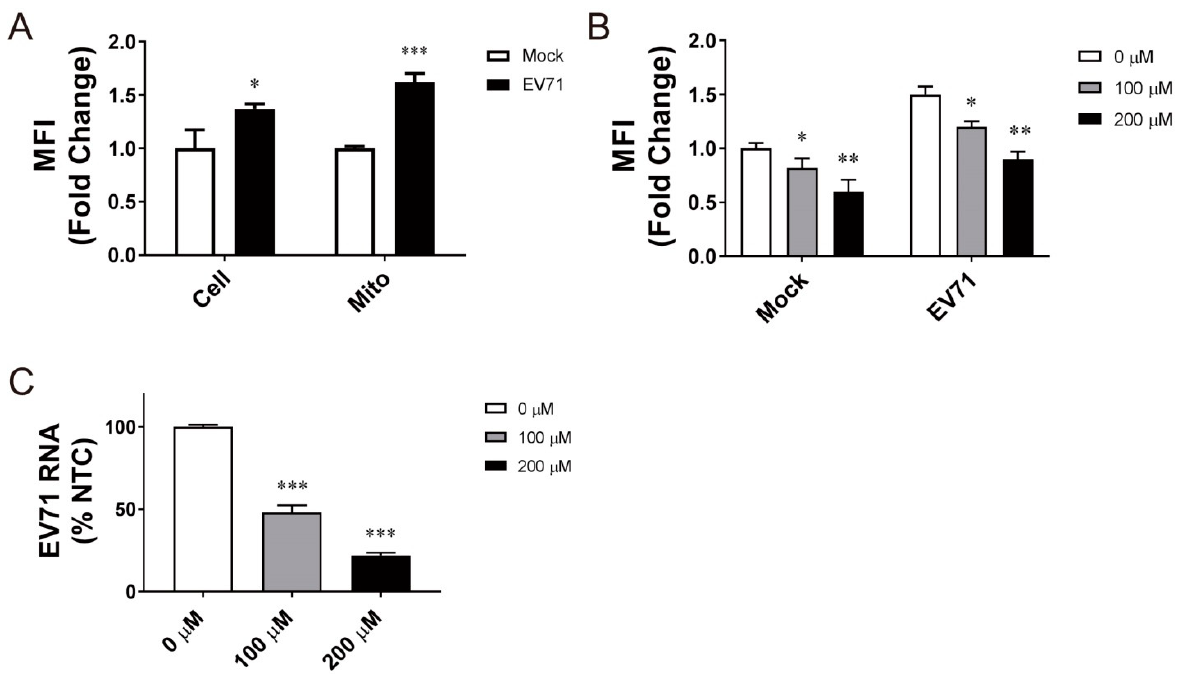
Figure 1. Mitochondrial ROS generation essential to EV71 replication. ( A ) Vero cells were mock infected ( Mock ) or infected ( EV71 ) with BrCr virus at an MOI of 1.25, and stained with CellROX Deep Red for quantification of total cellular ROS ( Total ) or with MitoSOX Red for quantification of mitochondrial ROS ( Mito ) at 24 h post-infection. The MFI is expressed as fold change relative to that of mock-infected cells. The results are mean ± SD, n = 6. * p < 0.05, *** p < 0.005 vs. mock-infected cells. ( B ) Vero cells were mock infected ( Mock ) or infected ( EV71 ) with BrCr virus at an MOI of 1.25; treated without or with 100 µ M and 200 µ M Mito-TEMPO; and stained with MitoSOX Red at 24 h post-infection. The MFI is expressed as fold change relative to that of untreated mock-infected cells. The results are mean ± SD, n = 6. * p < 0.05, ** p < 0.01 vs. mock-infected cells. ( C ) Cells were mock infected ( Mock ) or infected ( EV71 ) with BrCr virus at an MOI of 1.25; treated without or with 100 µ M and 200 µ M Mito-TEMPO; and extracted for determination of EV71 genomic RNA. The RNA level is expressed as the percentage of that of untreated infected cells. The results are mean ± SD, n = 6. *** p < 0.005 vs. infected